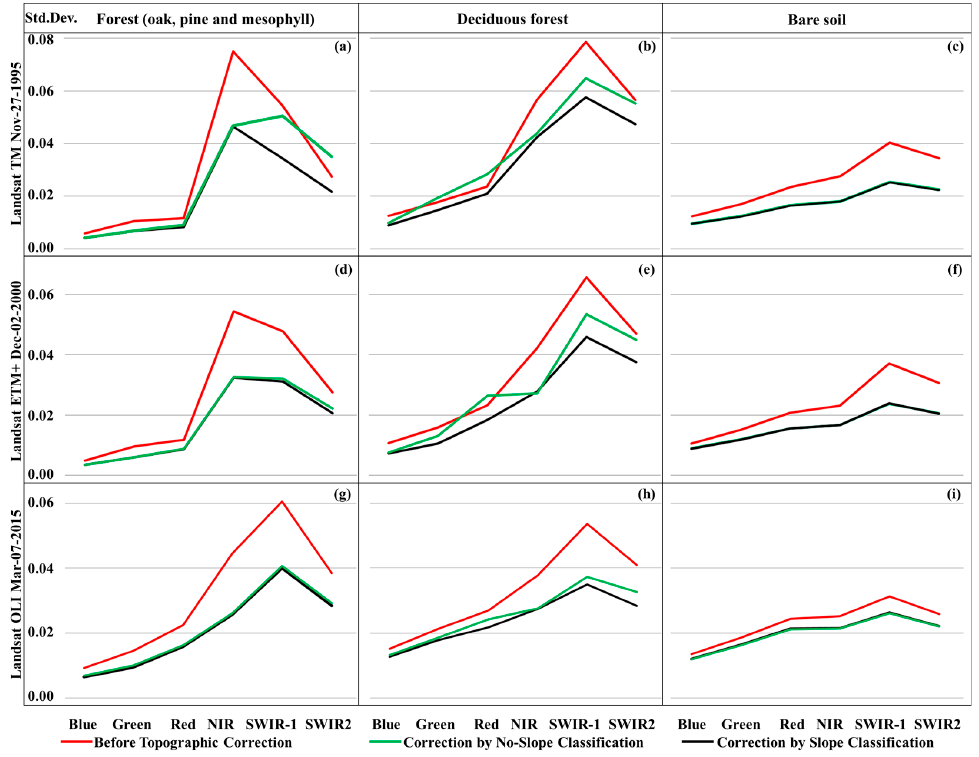
Figure 5. Mean standard deviation before and after topographic corrections. ( a , d , g ) Forest areas; ( b , c , h ) deciduous forest; ( c , f , i ) bare soil for the dates of study.